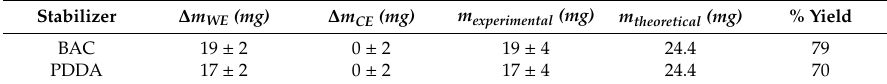
Table 1. The process e ffi ciency for the preparation of nanocolloids, expressed in terms of nanodispersed Zn masses, and % yields.